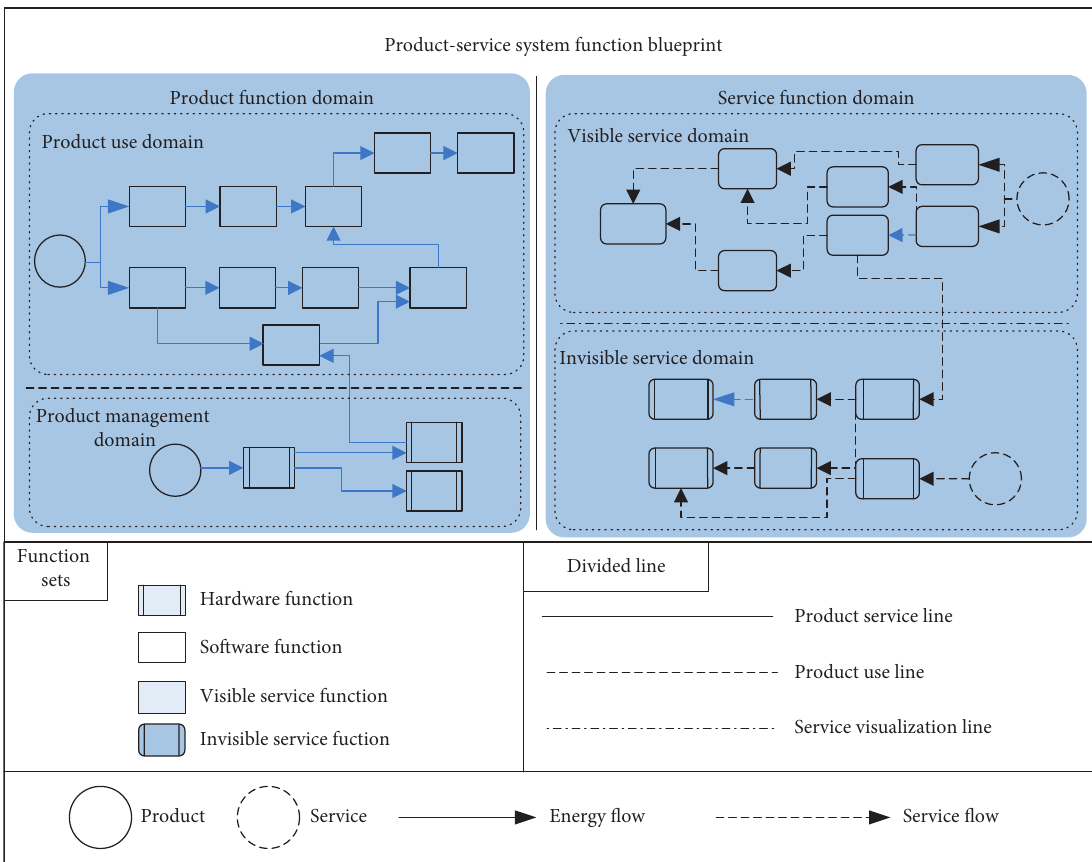
Figure 2: PSS function